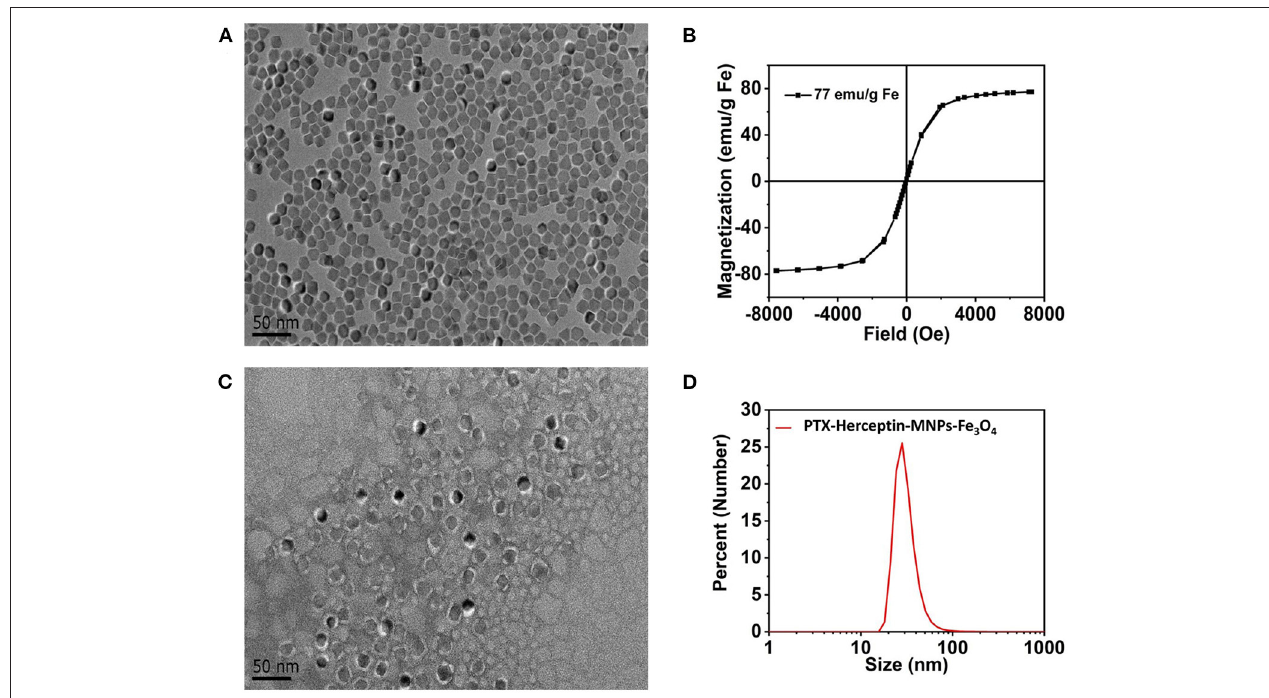
FIGURE 1 | (A) TEM image of Fe 3 O 4 @OA nanoparticles. (B) Hysteresis loops of Fe 3 O 4 @OA nanoparticles measured at 300K. (C) TEM image of PTX-Herceptin-MNPs-Fe 3 O 4 . (D) DLS size measurement of PTX-Herceptin-MNPs-Fe 3 O 4